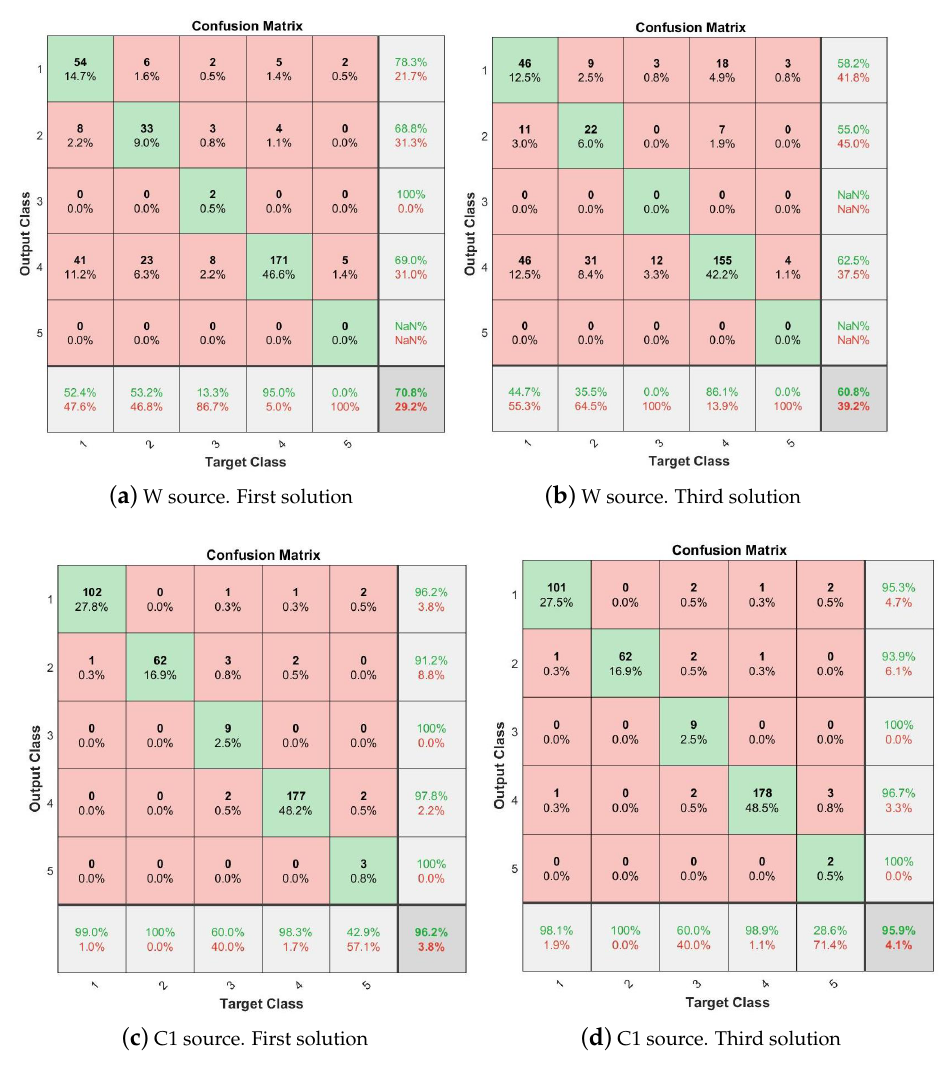
Figure 13. Confusion matrices obtained in the testing phase, for the first ( left ) and third ( right ) solution of the Pareto Front, using W and C1 sources.